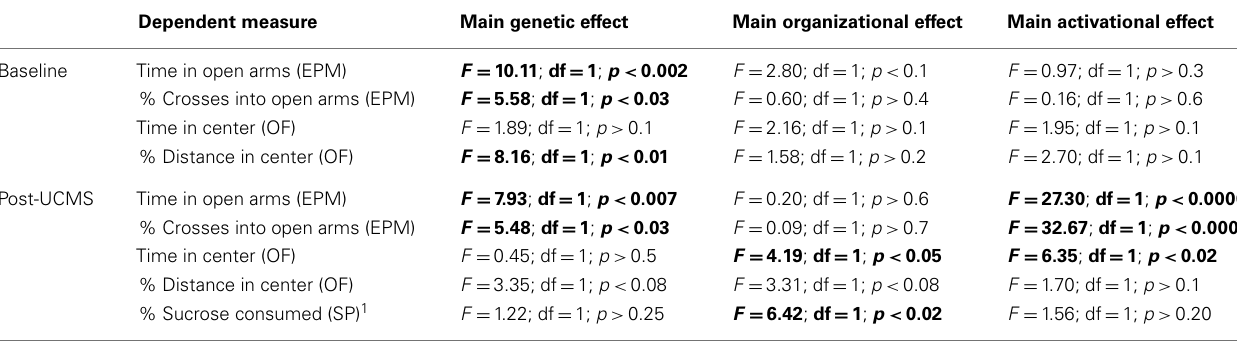
TableA2 | Statistical values associated with baseline (top) and post-UCMS (bottom) emotionality measures in FCG